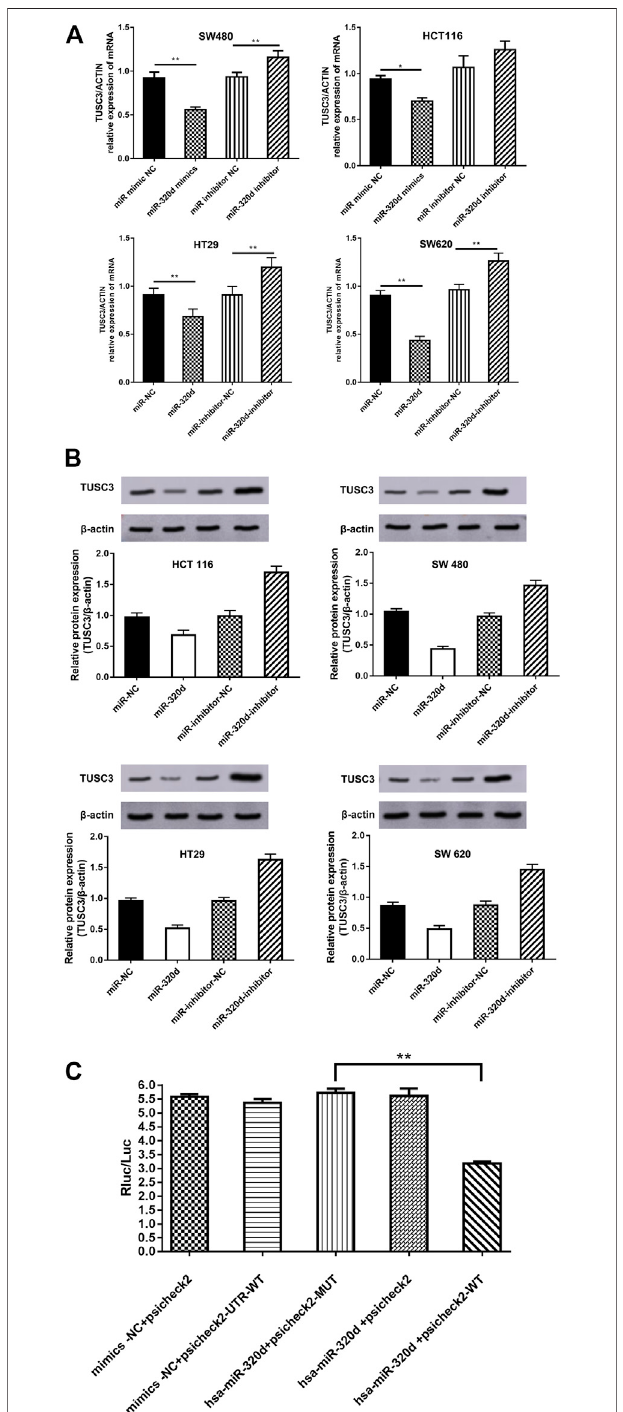
FIGURE4 | miR-320d targets the 3 ′ -UTR of TUSC3 mRNA. (A) qRT- PCR analysis of TUSC3 mRNA expression in EGFR-positive CRC cells transfected with the indicated miRNAs. (B) Western blots of TUSC3 in EGFR- positive CRC cells transfected with different miRNAs. (C) Luciferase activity of reporter plasmids carrying wild-type or mutant TUSC3 3 ′ -UTR in EGFR-positive CRC cells co-transfected with the indicated miRNAs. Assays were performed in triplicates. Mean ± SD is shown. Statistical analysis was conducted using Student ’ s t test. * p < 0.05. ** p < 0.01.